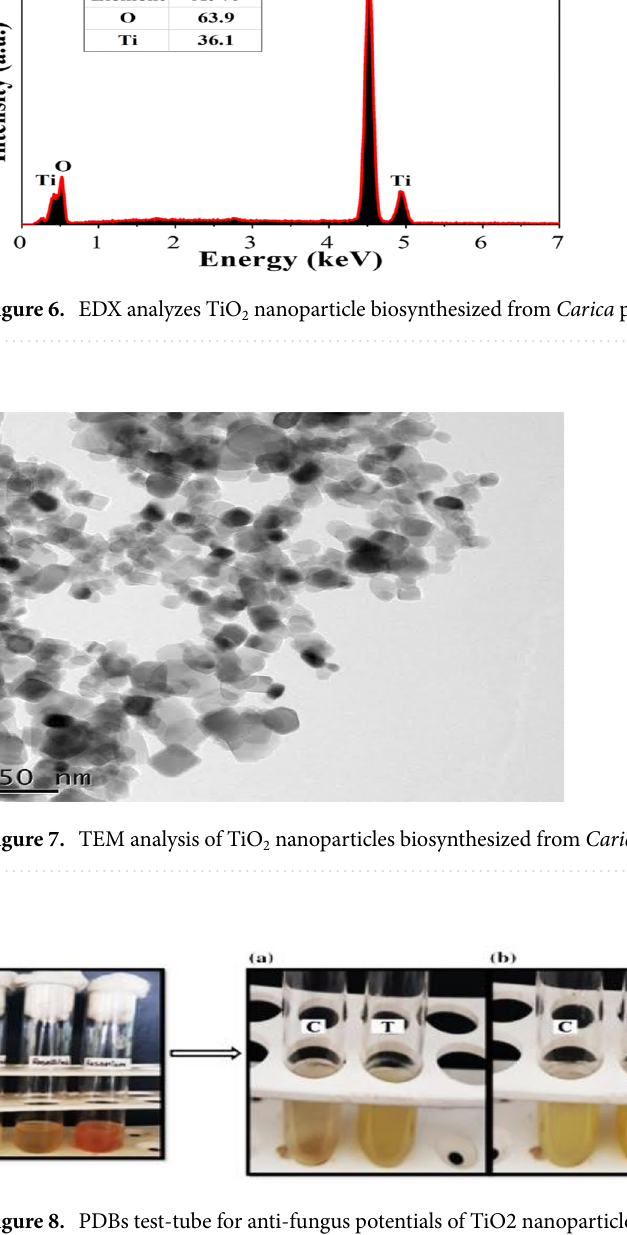
Figure 8. PDBs test-tube for anti-fungus potentials of TiO2 nanoparticles ( a ) Sclerotinias sclerotiorums , ( b ) Rosellinia necatrixs , ( c ) Fusariums